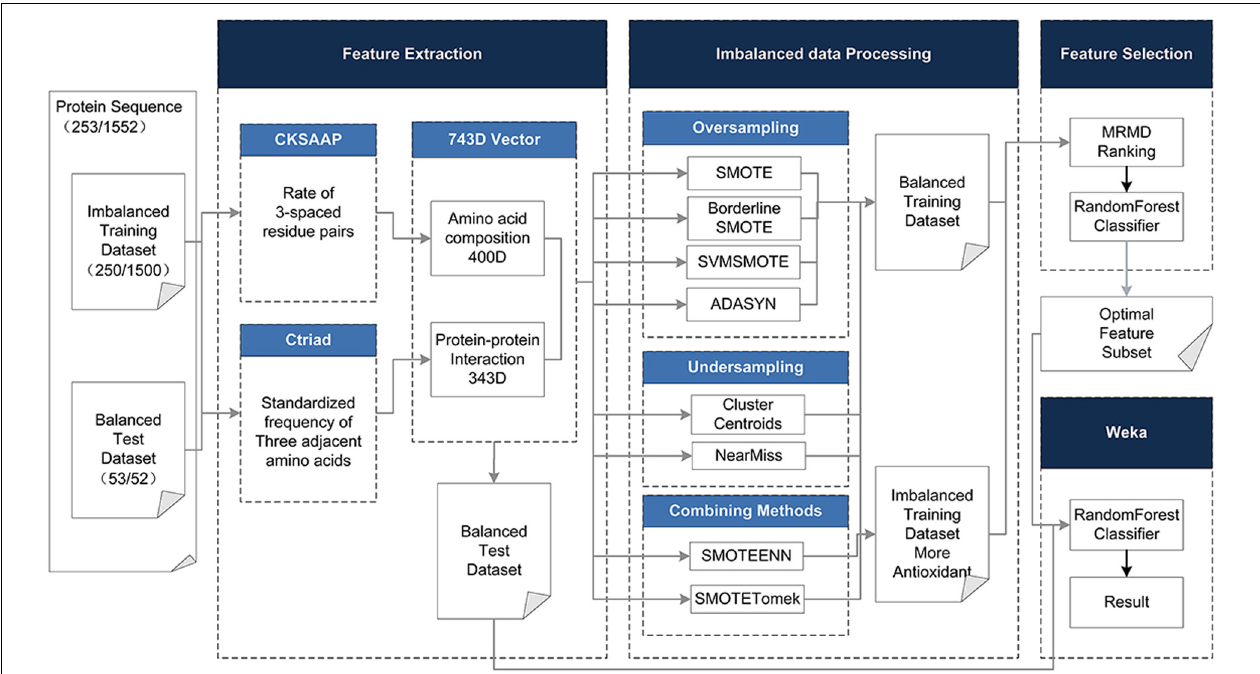
FIGURE 1 | The method flowchart. The original dataset (training and test dataset) is processed in four phases. (1) Using CKSAAP and CT to extract 743D features. (2) In the unbalanced data processing phase, eight methods are adopted to balance the training dataset. (3) In the feature selection phase, the 743D features by MRMD score are ranked and the optimal feature set is selected by Random Forest classifier. (4) Use the selected feature subset to classify the test set to get the final result.